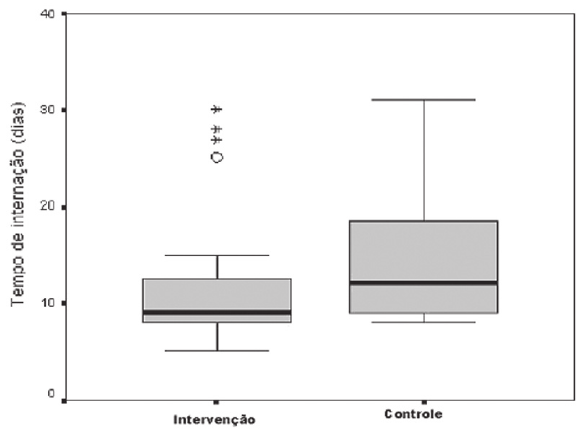
Fig. 5 - Tempo de internação hospitalar